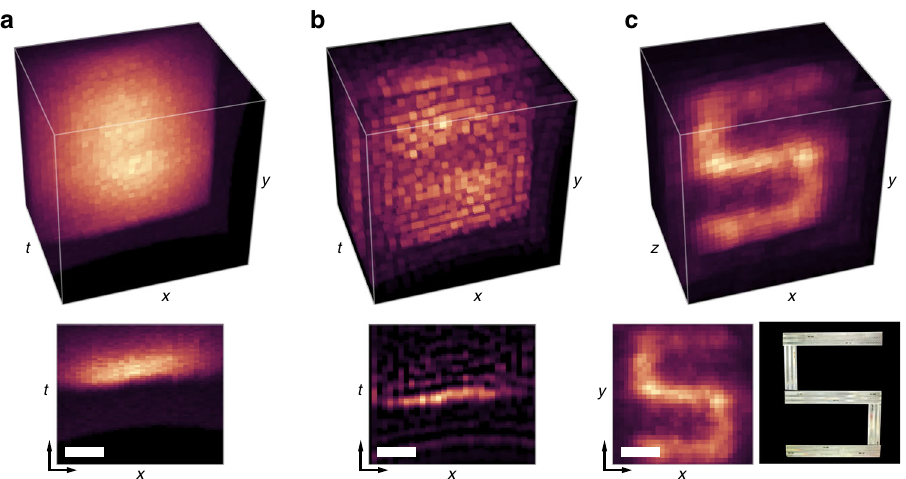
Fig. 2 Overview of the reconstruction procedure. The captured time-resolved measurements ( a ) are deconvolved with the calibrated diffusion operator (cid:2) Φ to compensate for the time delay induced by the scattering layer and estimate a measurement volume without diffusive scattering effects ( b , top). An x – t slice shows the estimated streak measurement ( b , bottom). Applying a confocal inverse fi lter recovers the hidden retrore fl ective letter ‘ S ’ ( c , top), which resembles a photograph of the hidden scene ( c , bottom). The reconstructed volume measures 60 cm by 60 cm by 50 cm along the x, y, and z dimensions, respectively, and a gamma of 1/3 is applied for visualization. Scalebars indicate 15 cm. The measurement volume is captured with a 1 min. acquisition time (60 ms per spatial sample). An overview of the reconstruction procedure is provided in Supplementary Movie